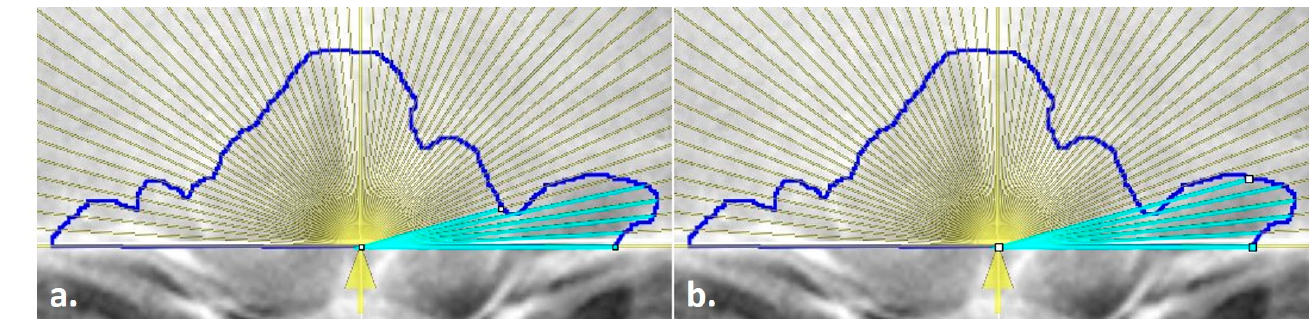
Figure 2. Line endpoint placement on the outlined frontal sinus with an overlay measurement aid (yellow lines); ( a ) line placed on the innermost sinus contour but not at the outermost intersection with the yellow ray, ( b ) line extended to the outermost intersection of the yellow ray and the blue sinus outline, following the method of Cox et al. [16].